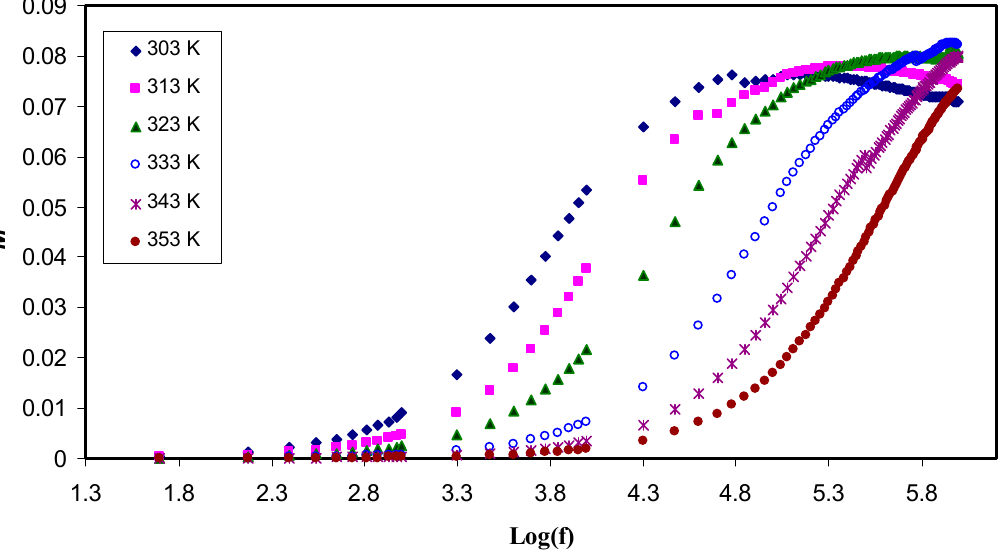
Figure 9. Imaginary part of the electric modulus ( M ”) as a function of the logarithm of frequency ( f ) at di ff erent temperatures. It is obvious that M” decreases with increasing temperature at high frequency region while it has a low value at the low frequency region due to the suppression of the electrode polarization.